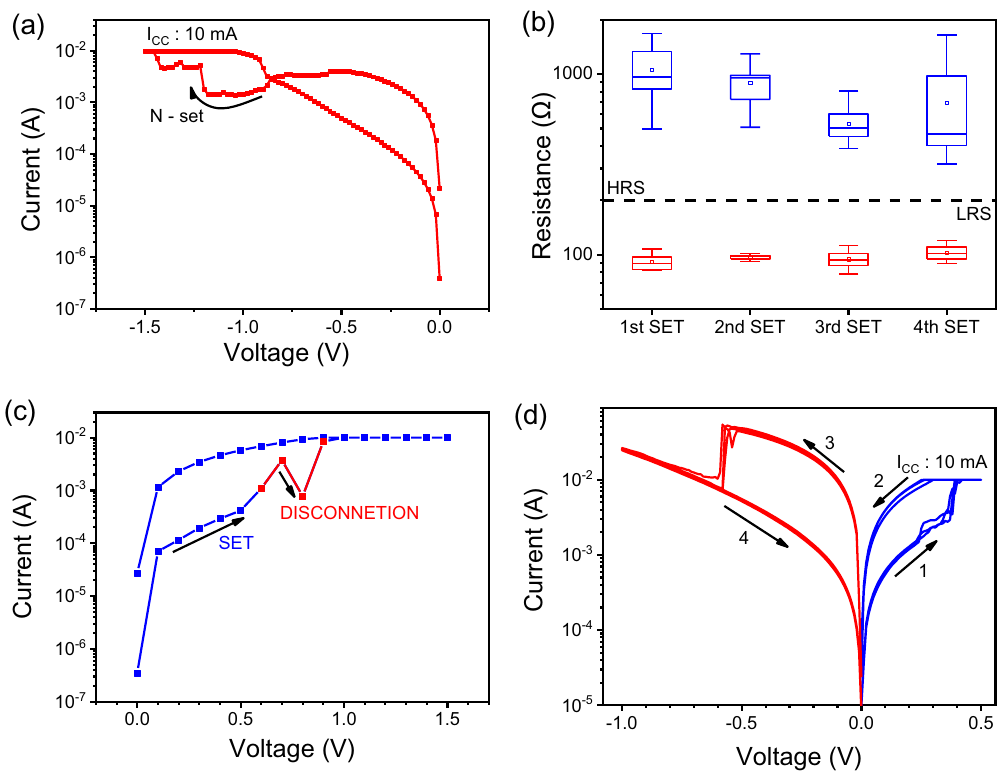
Figure 4. Nonideal resistive switching. ( a ) N-set behavior after reset. ( b ) HRS and LRS distributions after N-set. ( c ) Temporal disconnection of filament in the HRS. ( d ) Typical I–V characteristics of Ag/ZnO/Pt